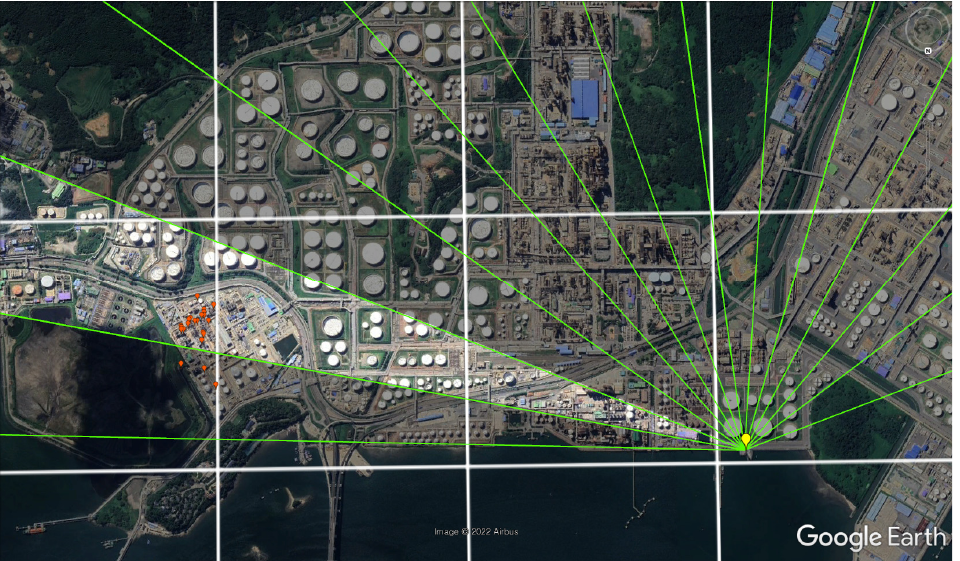
Figure 12. The actual handling information of vinyl chloride (orange dots) in monitoring section G2. (Source: Google earth).